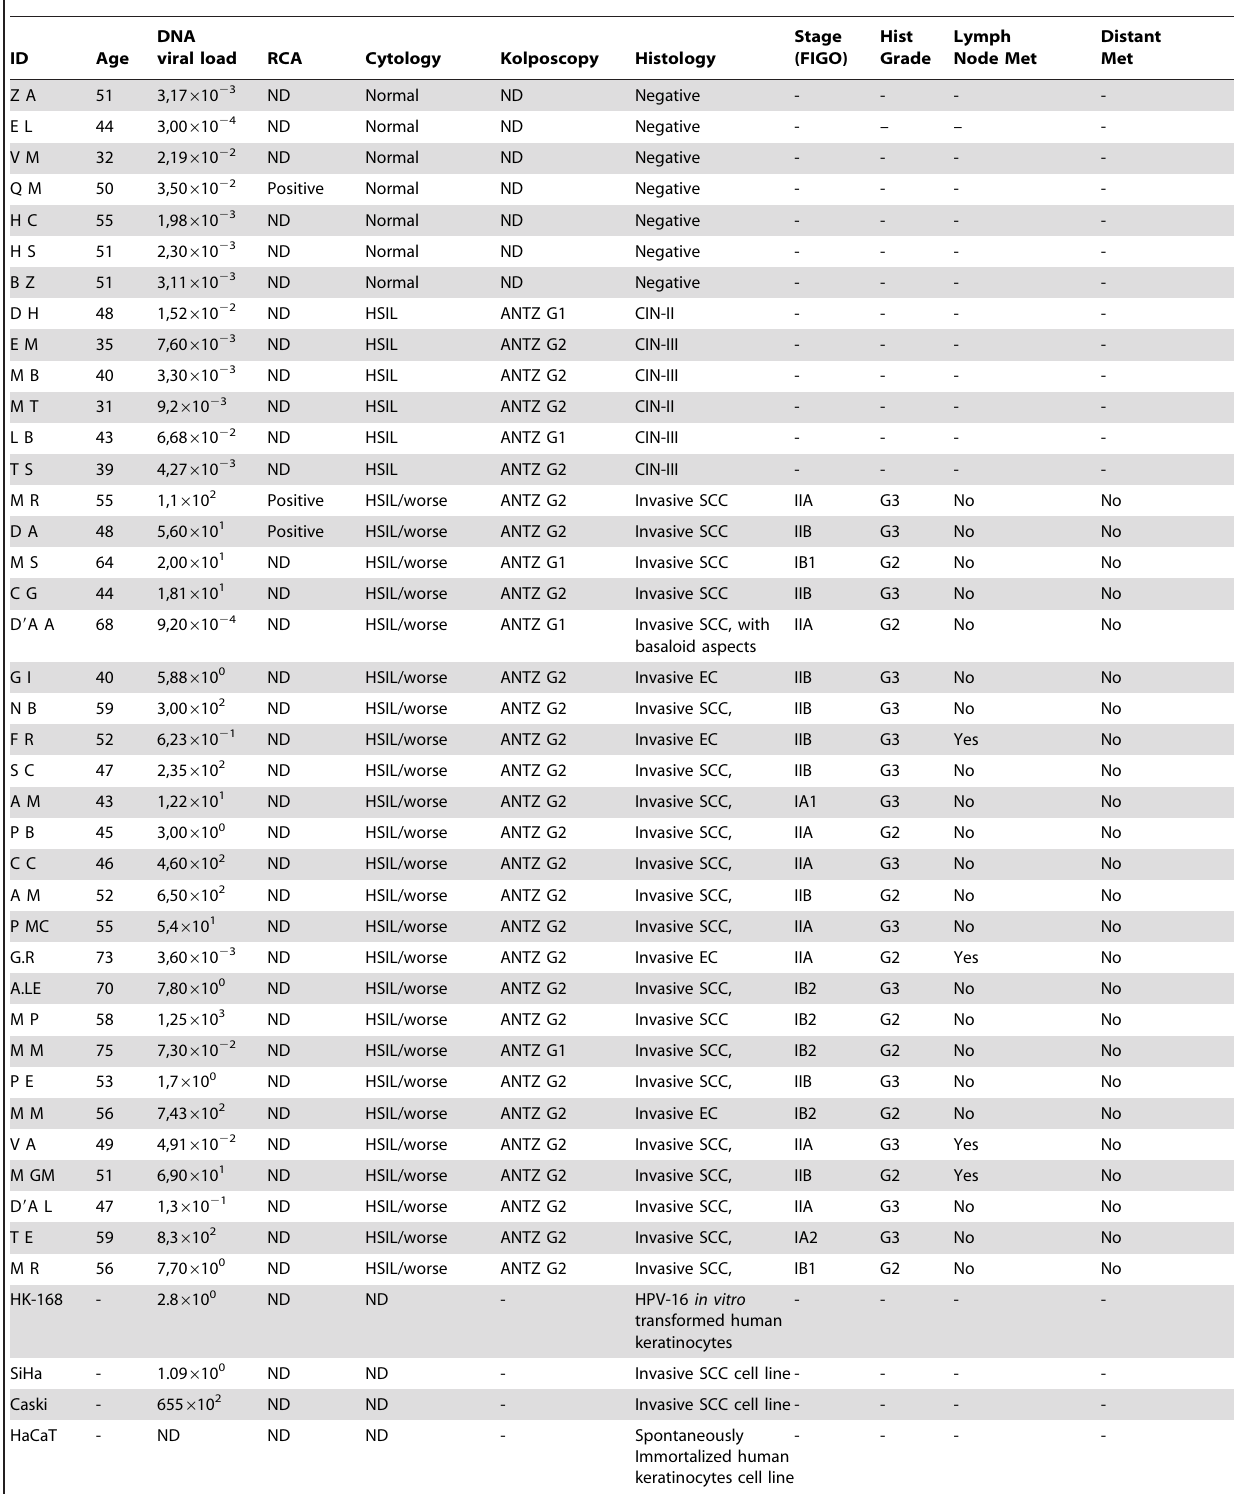
Table 2. List of HPV-16 positive patients together with their major clinical, virological and pathological determinants.